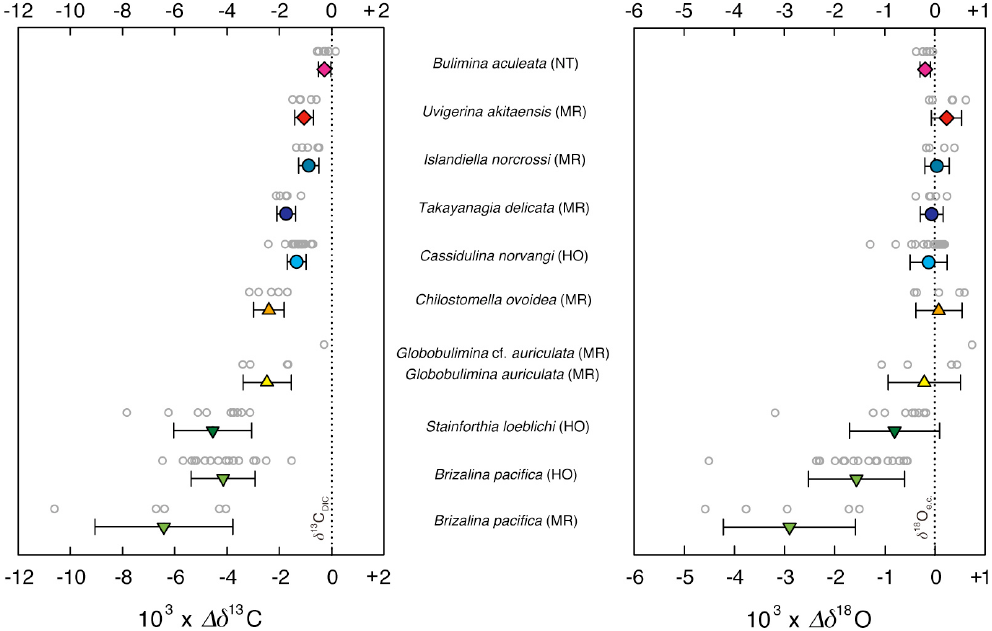
Fig. 4. Variations in 1δ 13 C and 1δ 18 O values of individual benthic foraminifera together with average values. Open circles are individual